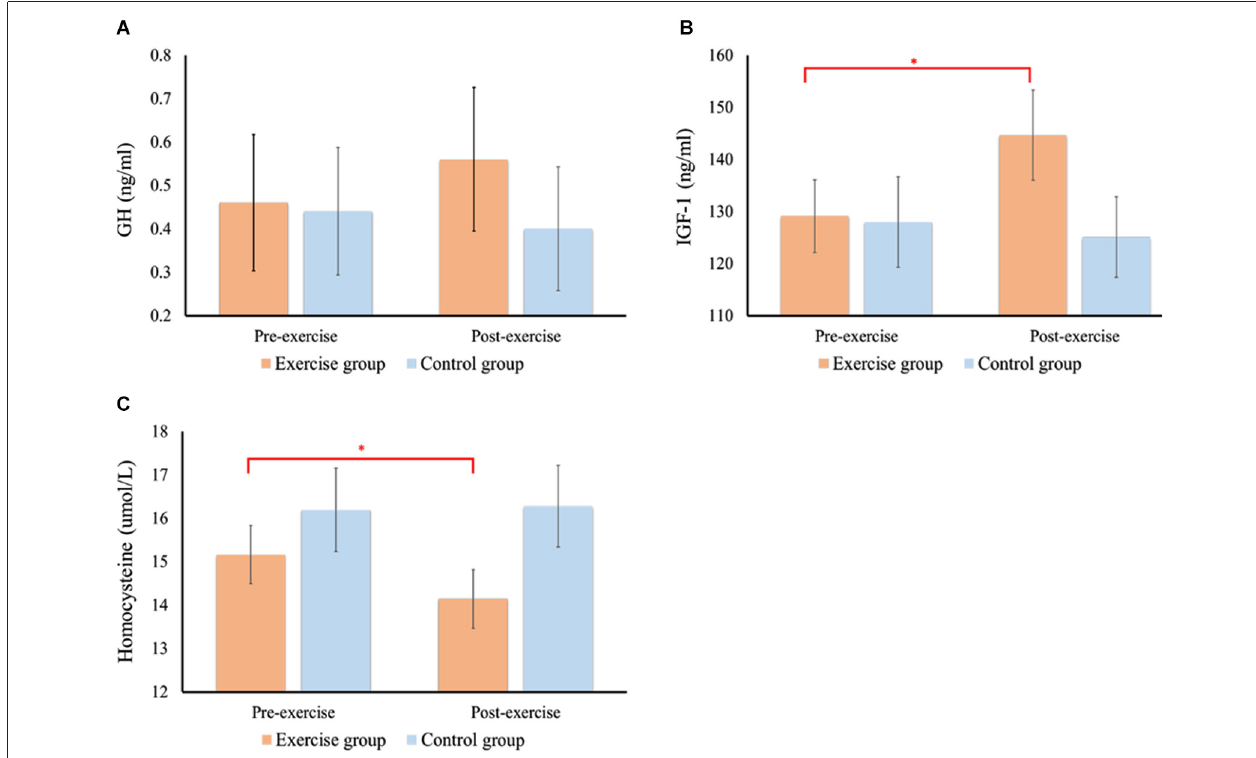
FIGURE 4 | Changes in serum levels of GH (A), IGF-1 (B), and homocysteine (C) before and after 12 months in the exercise or control group . *Significantly different ( p < 0.05) from corresponding baseline values. Statistical values expressed as mean ±